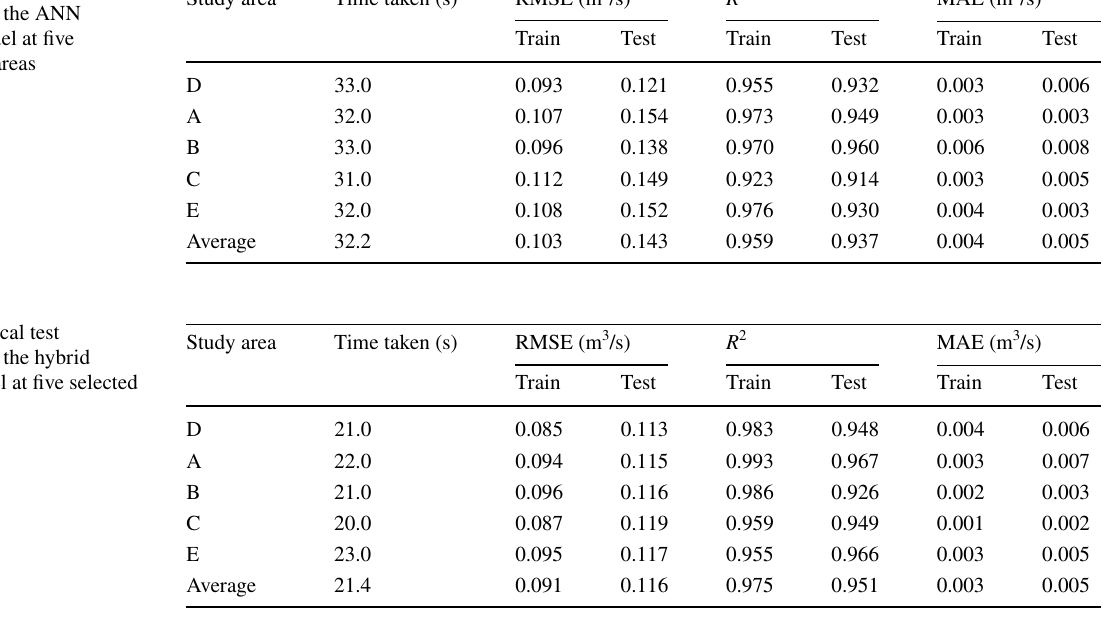
performance of the ANN standalone model at five selected study areas